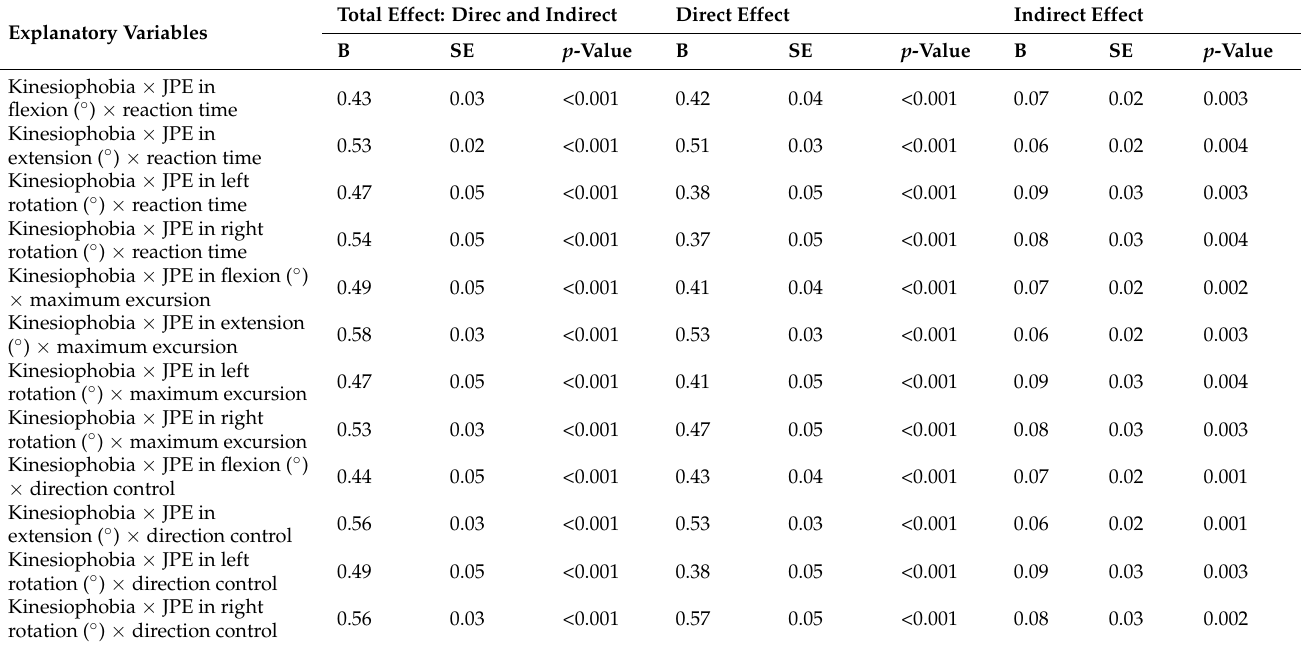
Table 4. Kinesiophobia as a mediation factor on the relationship between cervical JPS and limits of stability.